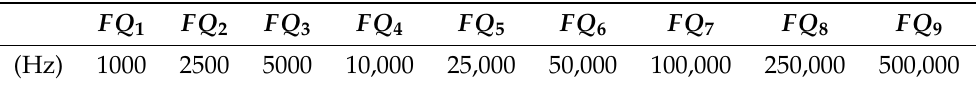
Table 2. Nine different frequencies in the range from 1 to 500 kHz are used for the impedance